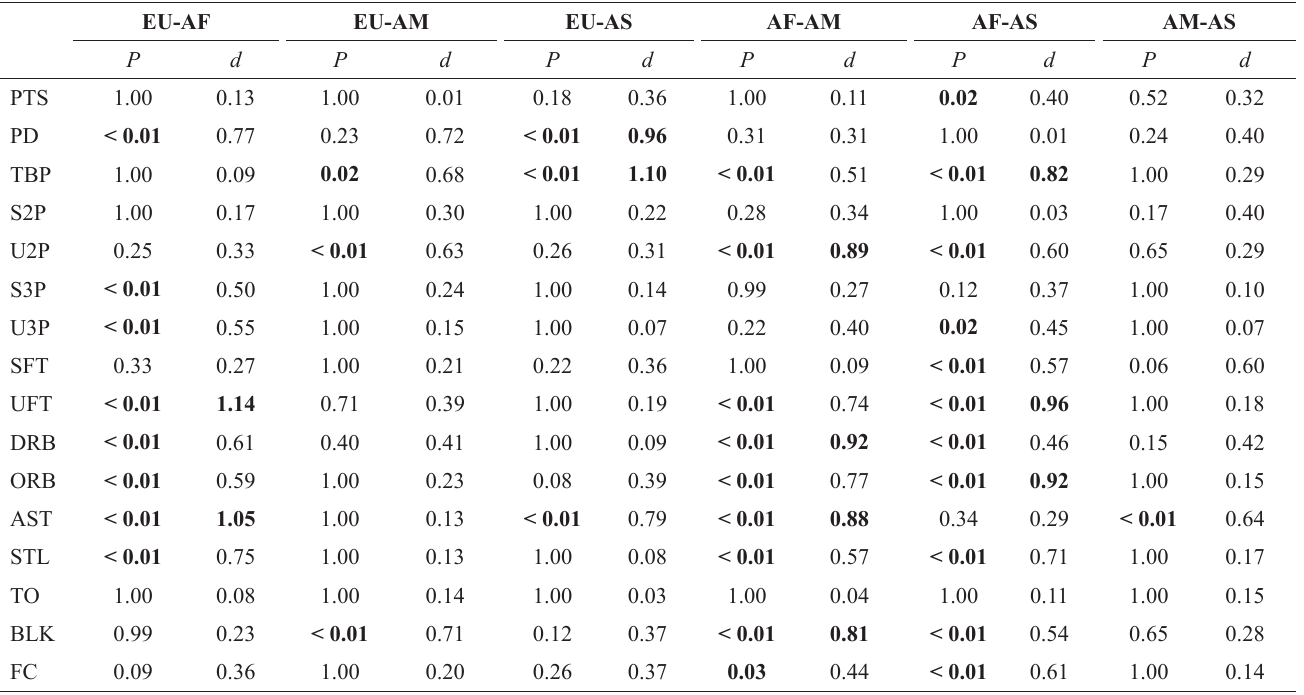
Table 3. Results of post hoc comparison between each continental championship for U18 men.